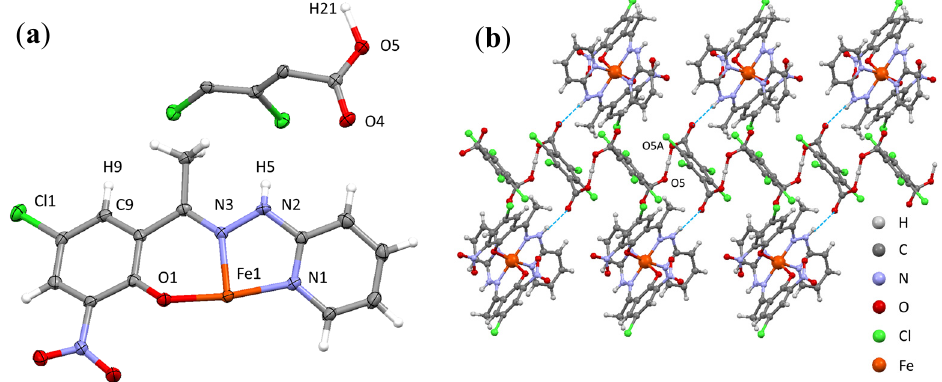
Figure 1. ( a ) Molecular structure of the asymmetric unit; ( b ) Molecular arrangement of the [Fe(HL1) 2 ] cation and the HCl 4 TPA anion. Blue lines represent the hydrogen bonds (N2–H5···O4).